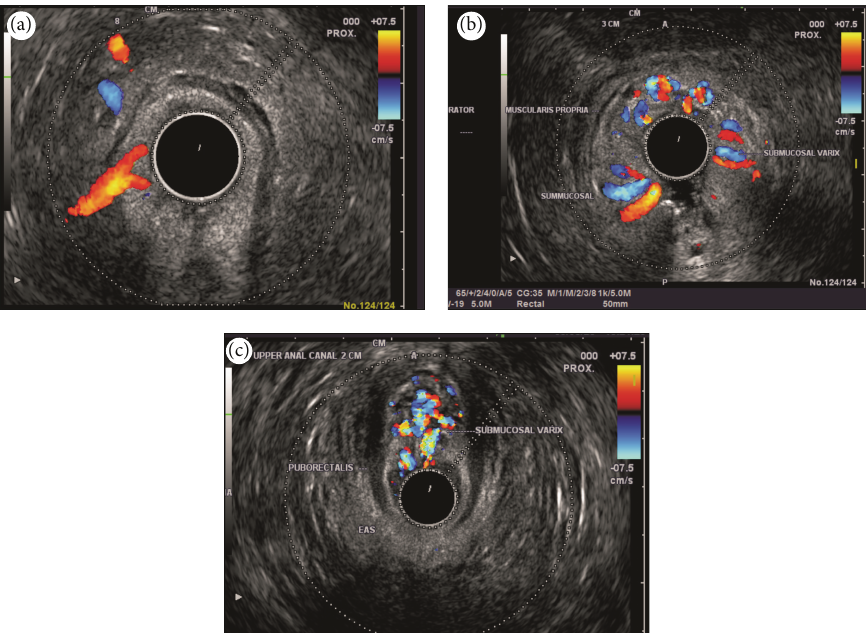
Figure 2: (a) An inflowing perforator of 3mm diameter noted in the right lateral wall of rectum. (b) As the scope is pulled down towards the anorectal junction, the varices are seen circumferentially in the submucosa. (c) The varices are seen going anteriorly towards the genital plexus.